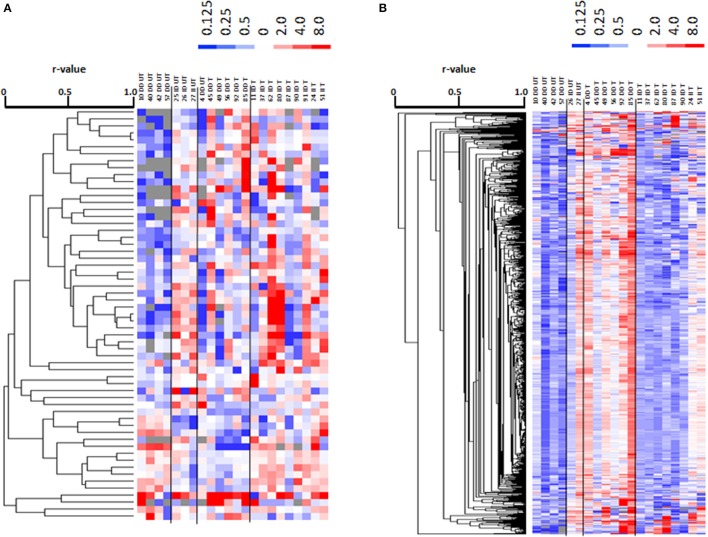
Profiling for ACE-I/D × training dependent metabolites post exercise. Cluster analysis of linear relationships between 59 altered metabolite compounds (A) and 780 altered non-polar (lipid) species (B) in a subset of subjects (7 untrained and 15 endurance-trained) 30-min post- vs. pre-exercise. Alterations in levels are given in color code (up: red, down: blue) with the scale being indicated to top of each panel. On top the data are labeled by genotype (II, ID; DD) and training status (T, trained; UT, untrained) and subject number. To the right, the compound IDs are indicated according to the human metabolome data base (HMDB). Dendrograms to the left indicates the correlations between compounds. Lines separate profiles according to the I-allele. Unique and identified compound were subsequently identified. Note: A clearly distinguishable pattern of alterations in lipid levels is evident for the trained vs. untrained subjects with the ACE-DD genotype.